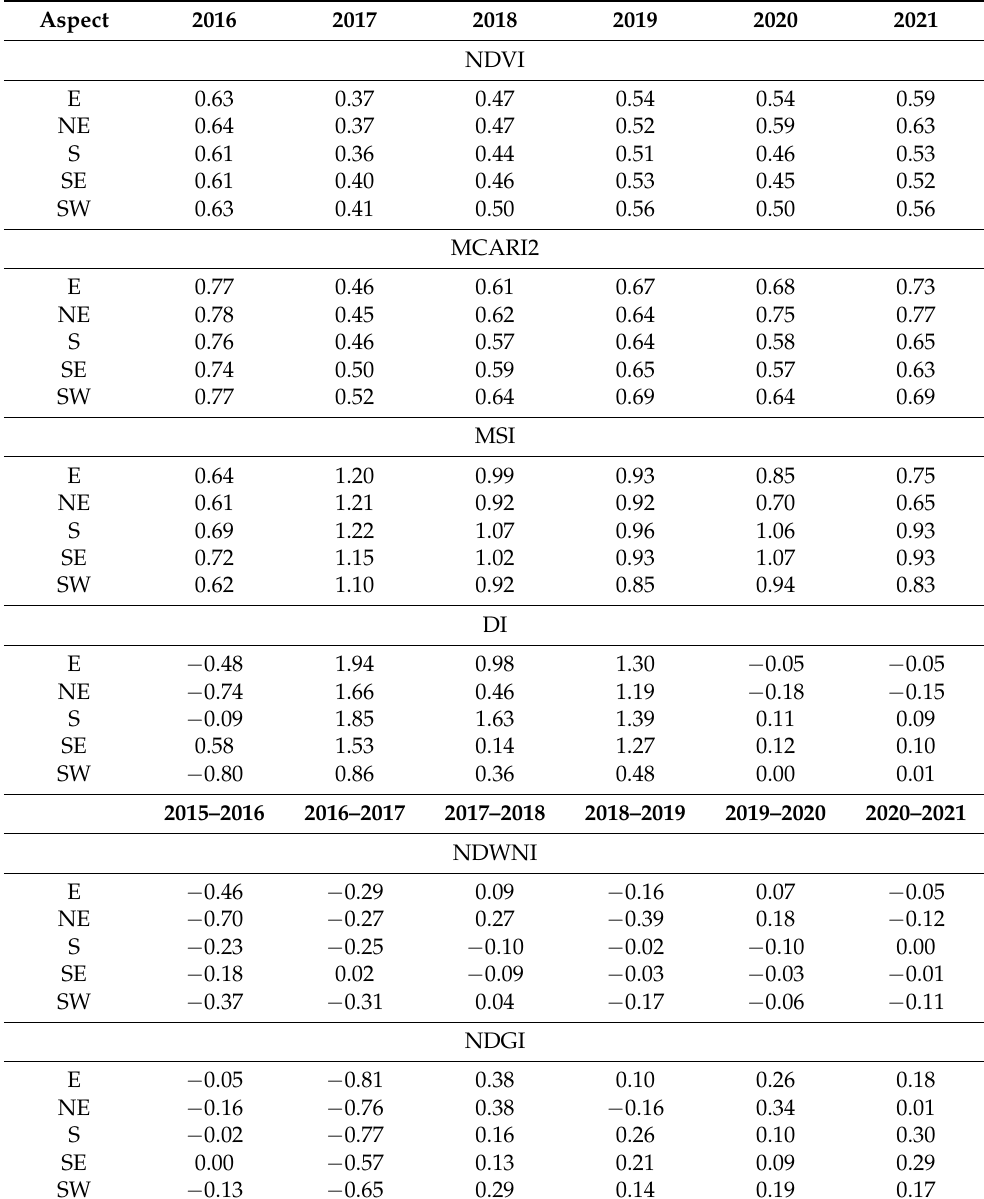
Table 2. Mean values of the spectral indices for the different slope aspects in the studied years.